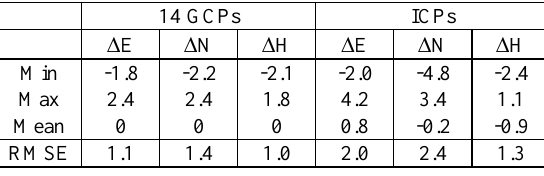
Table 1. Statistics of the residuals found on the GNSS points, in